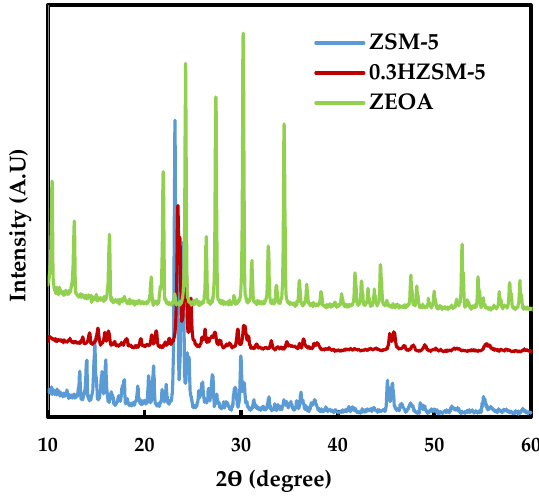
Figure 2. Diffractograms of ZSM-5, 0.3HZSM-5 and ZEOA.